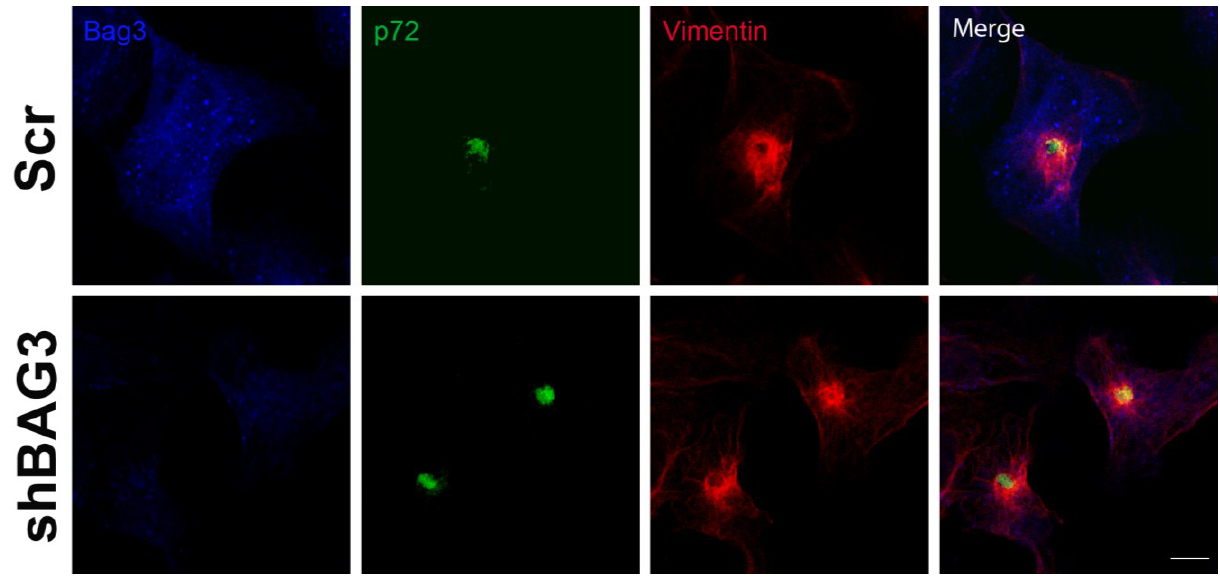
Figure 4. Effect of the inhibition of both BAG3 and HDAC6 pathways in VF